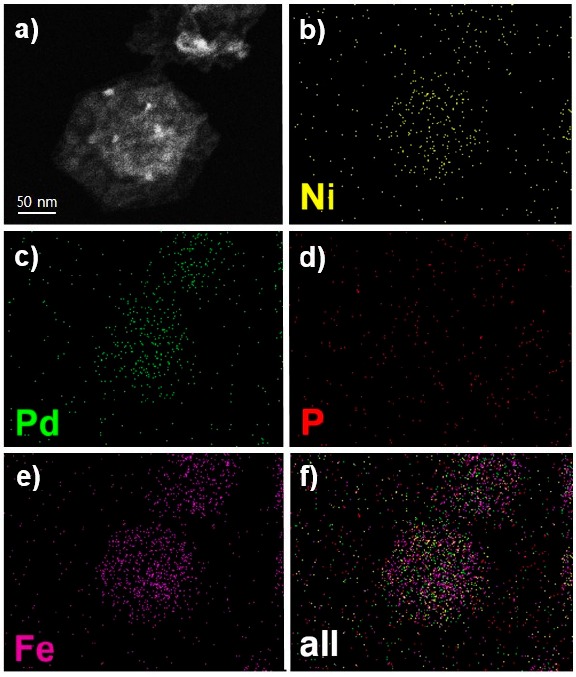
Figure 2. STEM-EDS elemental maps of the NPFNP-2. ( a ) HAADF-STEM image of the particle; ( b – e ) elemental maps for Pd, Fe, Ni, and P, respectively; ( f ) images with overlaid maps. Table 1. ICP-AES data of the fabricated nanoparticles.